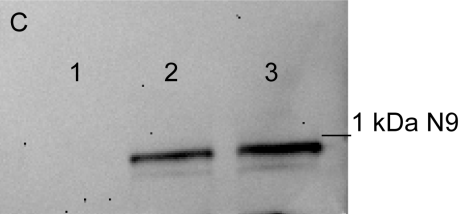
Figure 8. 9-mer peptide of Tag7 binds to TREM-1 and prevents the development of cytotoxic activity of PBMCs. ( A ) Cytotoxicity of PBMCs treated with N3, N9 or N15 peptide. Concentration in all cases—1 nmol/L. ( B ) Influence of N9 and N15 peptides upon development of cytotoxic lymphocytes in PBMCs treated with Tag7, Hsp70 and N3 for 6 days. N9 or N15 was added to PBMCs before 1 h of activation with Tag7, Hsp70 or N3. Cytotoxicity was measured after 24 h of incubation with K562 cells (one-way ANOVA, p -value: *** < 0.05, ** < 0.03, *< 0.01 vs. PBMCs). ( C ) Elution of biotin-N9 peptide from sTREM-1 conjugated with CNBr-activated sepharose: 1—washing before elution, 2—elution of N9 peptide, 3—control N9 peptide.